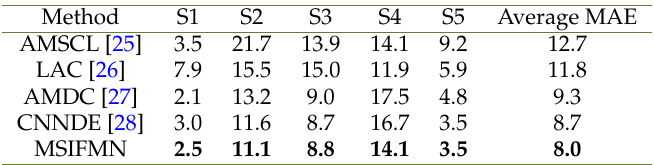
Fig. 8. Experimental results from the Mall dataset. The first column represents the original image; The second column represents the truth graph; The third column represents the predicted result. Table 3. Comparison with other state-of-the-art methods on Mall dataset.